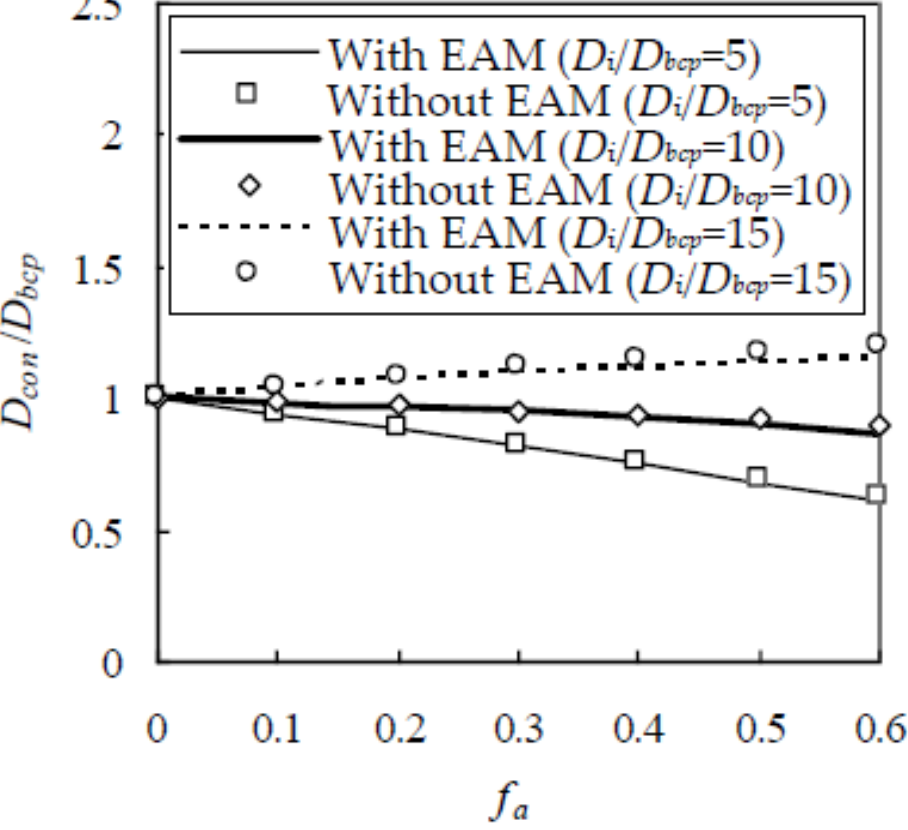
Figure 12. Comparison of estimated chloride diffusivity of concrete with and without equivalent aggregate model (EAM).